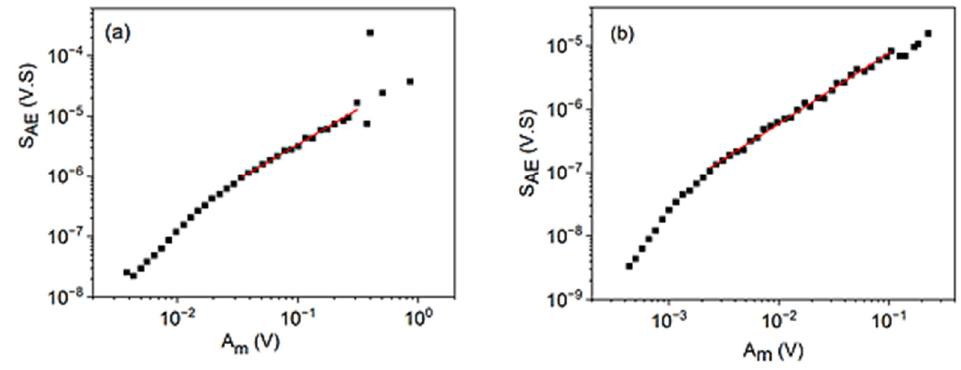
Figure 6. logS AE versus logA m plots for cooling in alloy A ( a ) at small, constant, external magnetic field (B = 250 mT) and for heating in alloy B ( b ) (at B = 0).